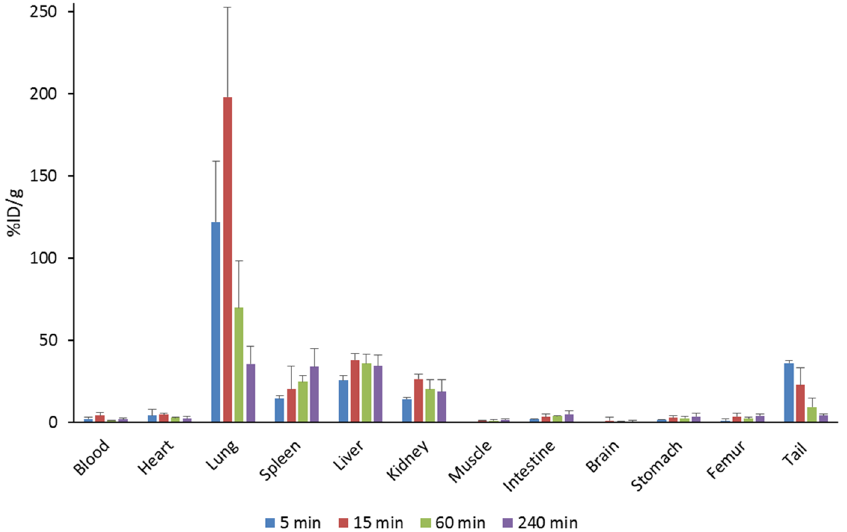
Figure 7. Biodistribution of 14 C ‐ labeled Pep19 ‐ 2.5 in NMRI mice.